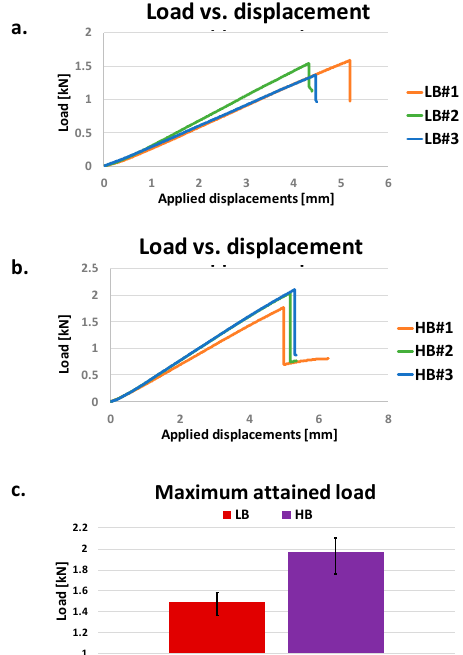
Figure 10. Experimental Load vs. Applied displacements in ( a ) low bridging sensitivity case, ( b ) high bridging sensitivity case; ( c ) max loads comparison. LB: low bridging; HB: high